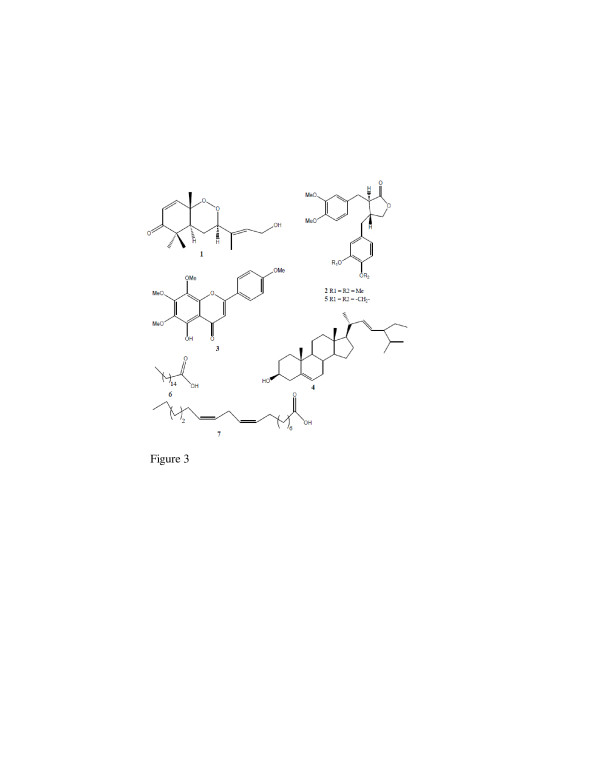
Structures of seven of twenty-nine pure compounds isolated and screened for antibacterial activity. Legend: Okundoperoxide (1) from S. striatinux, the only active compound was bacteriostatic on S. aureus; Matairesinol dimethyl ether (2), 5-Demethyl tangeretin (3), and Stigmasterol (4) from P. vulcanica; Bursehernin (5), Hexadecanoic acid (6) and Linoleic acid (7) from P. fernandopoioana.